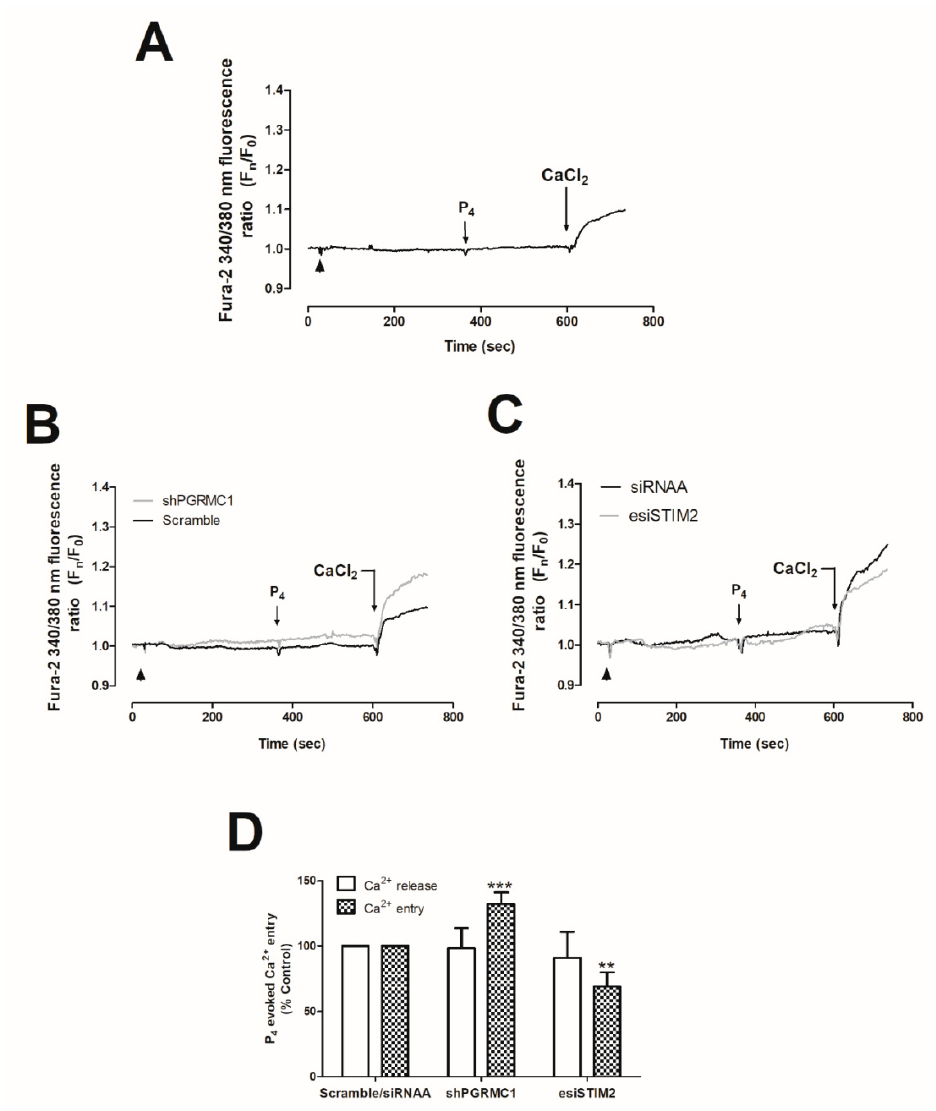
Figure 3. Progesterone (P 4 ) effects on Ca 2 + entry in MCF7 mock cells or in cells transfected with small hairpin siRNA against progesterone receptor membrane component 1 (shPGRMC1) and endoribonuclease-prepared siRNAs against the stromal interaction molecular 2 (esiSTIM2). MCF7